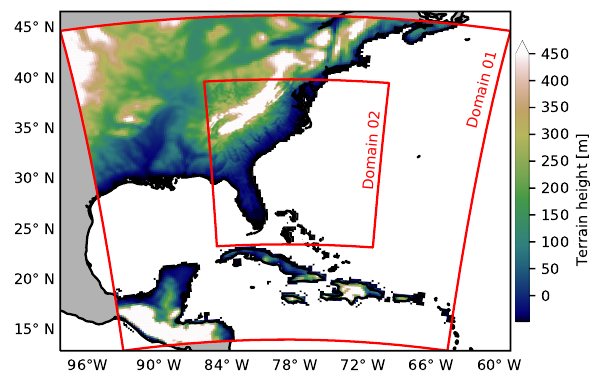
Figure 3. Horizontal extent and terrain elevation of atmosphere model domains in WRF, in which the horizontal resolution of the outer domain is 21.6km while that of the inner domain is